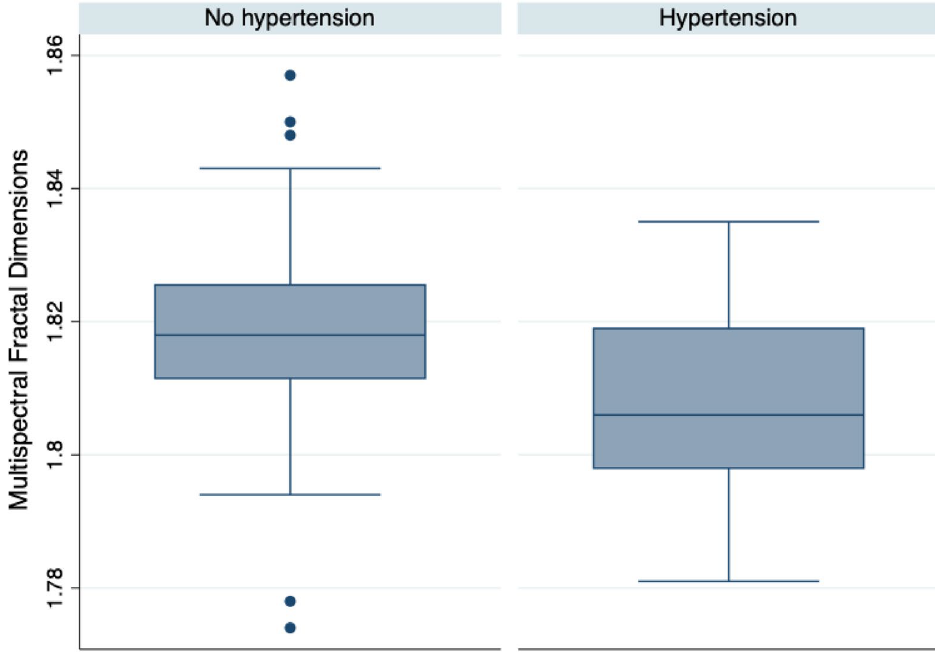
Figure 3. Box plot summarizing MSFD in glaucoma patients with and without systemic hypertension ( P = 0.036).